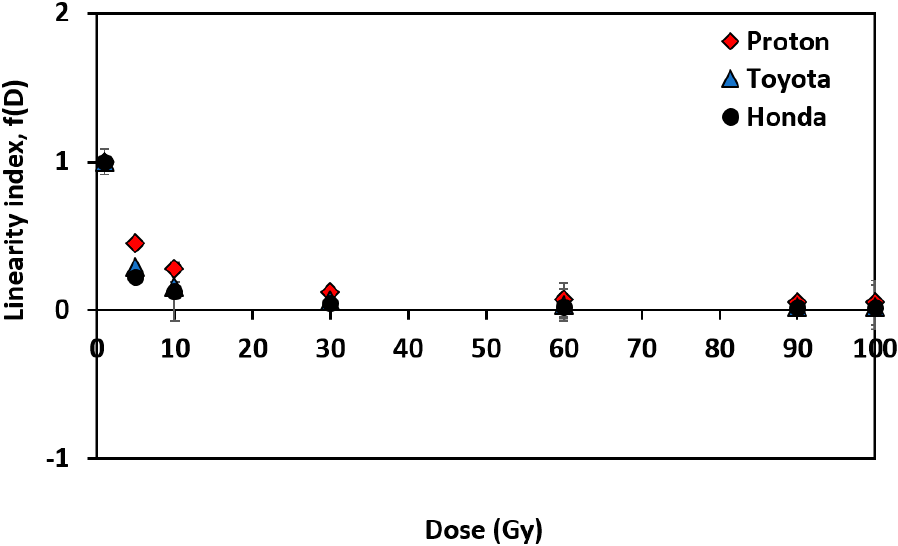
Figure 5. Linearity Index of the glass samples subject to 60 Co gamma-irradiation, for doses ranging between 1 Gy to 100 Gy.